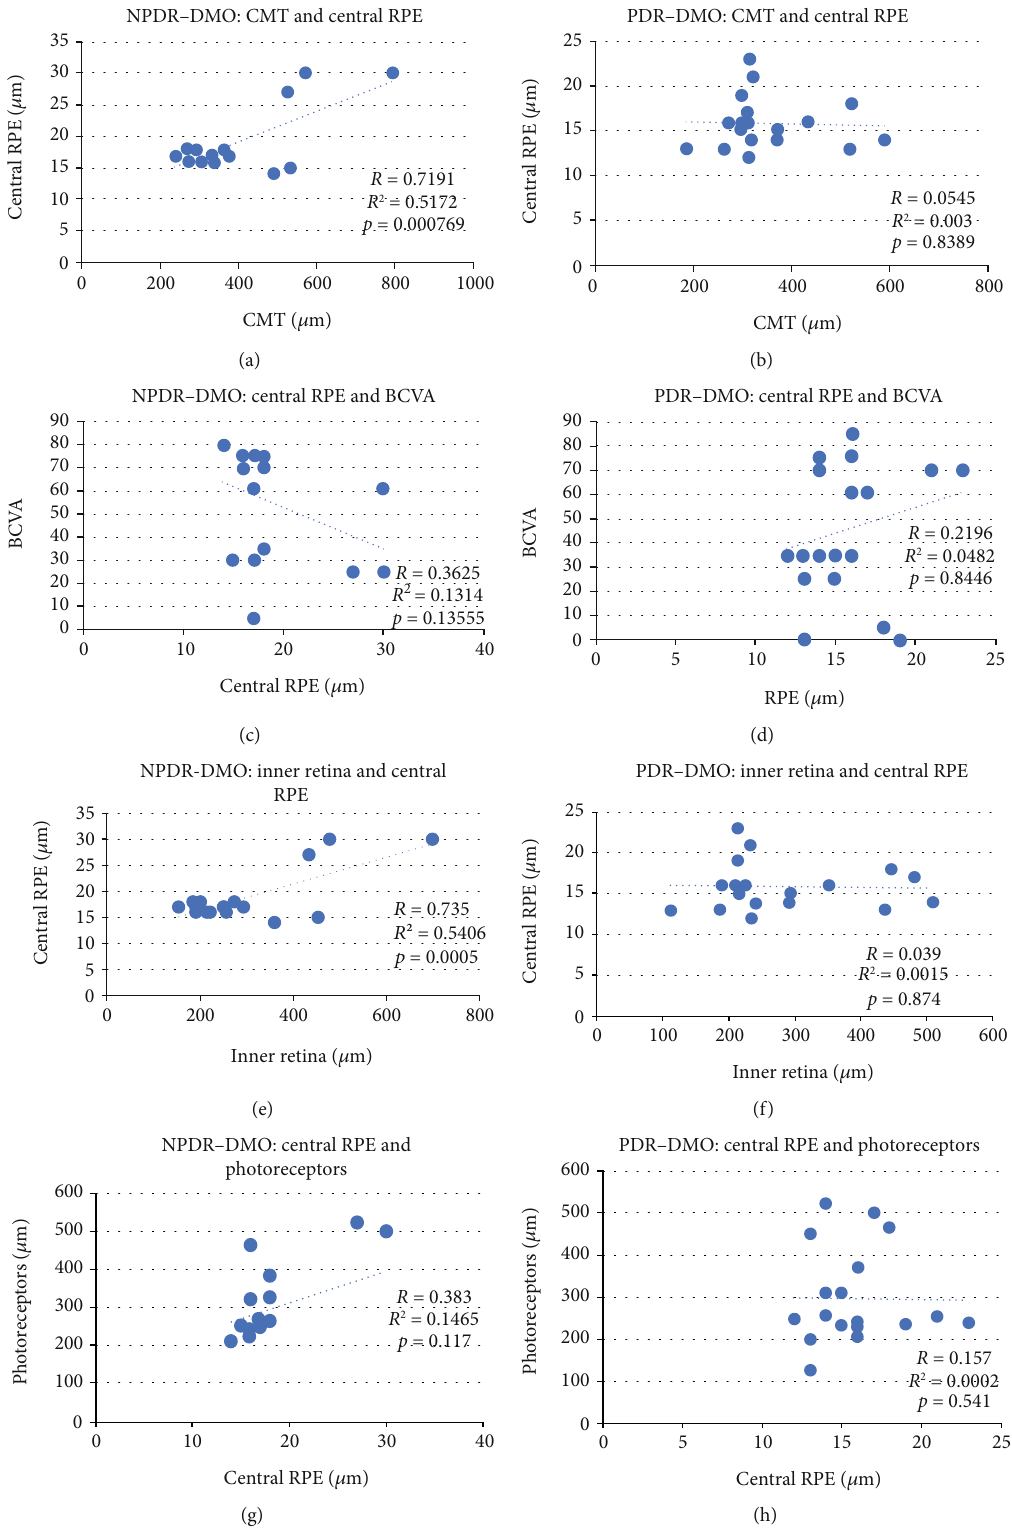
Figure 4: Scatterplots between di ff erent variables: (a) CMT and central RPE in NPDR-DMO; (b) CMT and central RPE in PDR-DMO; (c) central RPE and BCVA in NPDR-DMO; (d) central RPE and BCVA in PDR-DMO; (e) inner retina and central RPE in NPDR-DMO; (f) inner retina and central RPE in PDR-DMO; (g) central RPE and photoreceptors ’ thickness in NPDR-DMO; (h) central RPE and photoreceptors ’ thickness in